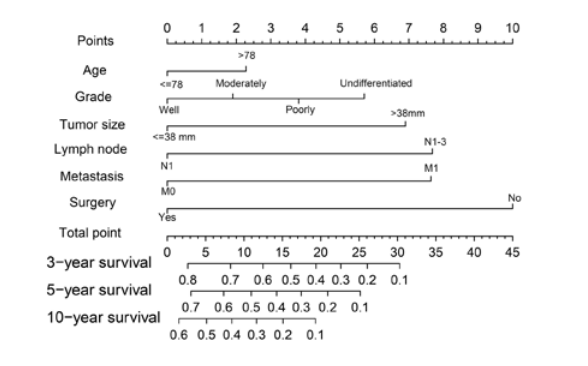
Figure 5: Novel nomogram estimated by clinical characteristics for the overall 3-, 5-, and 10-year survival rate in patients with primary pulmonary PA. Abbreviations: PA, papillary